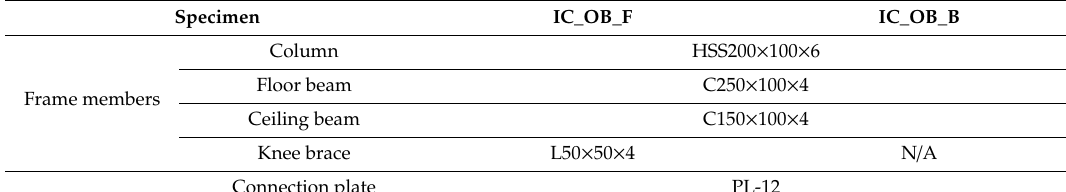
Table 1. Main features of two test specimens. (unit: mm).